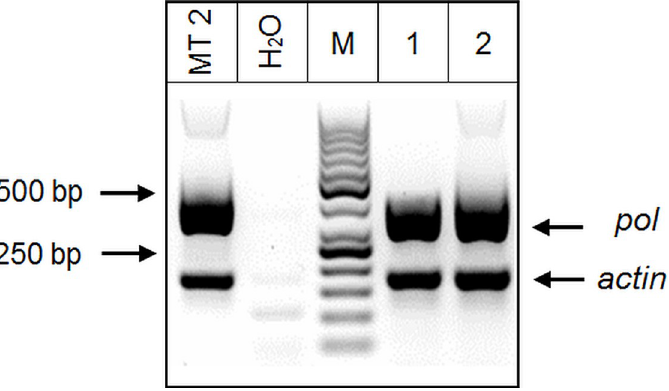
Fig 5. Detection of HTLV-1 pol gene by n-PCR from a positive German´s case with T-cell lymphoma. MT2 (positive control), H 2 O (negative control). Samples from German patient: line 1: DNA stored in 2011, obtained from tissue; line 2: DNA stored in 2014, obtained from blood. The arrows point to the band of pol and actin amplification and 50 bp DNA Ladder